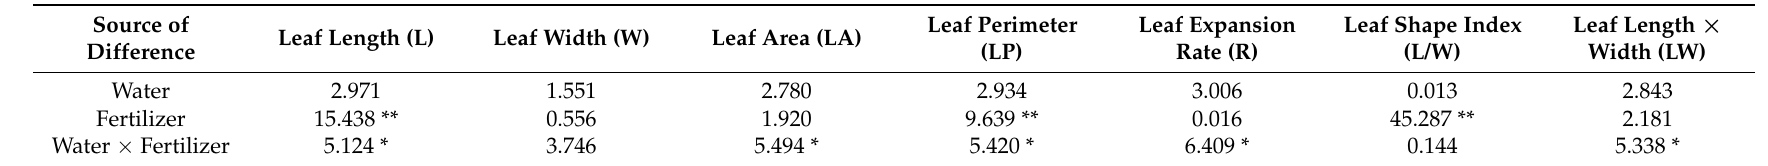
Table 5. Analysis of double factors of Eucalyptus leaf size after 45 days of treatment by F -value test.